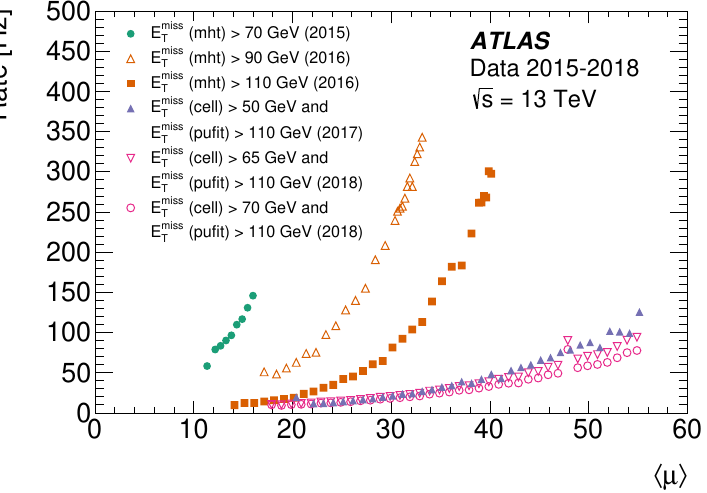
Figure 9. High-level trigger output rates, as a function of h (cid:22) i , shown separately for example runs in each year 2015{2018, for triggers HLT xe70 mht (2015), HLT xe90 mht and HLT xe110 mht (2016), HLT xe110 pufit (2017), HLT xe110 pufit xe65 and HLT xe110 pufit xe70 (2018). The HLT xe110 pufit trigger used during 2017 also included an implicit requirement of cell E miss 50